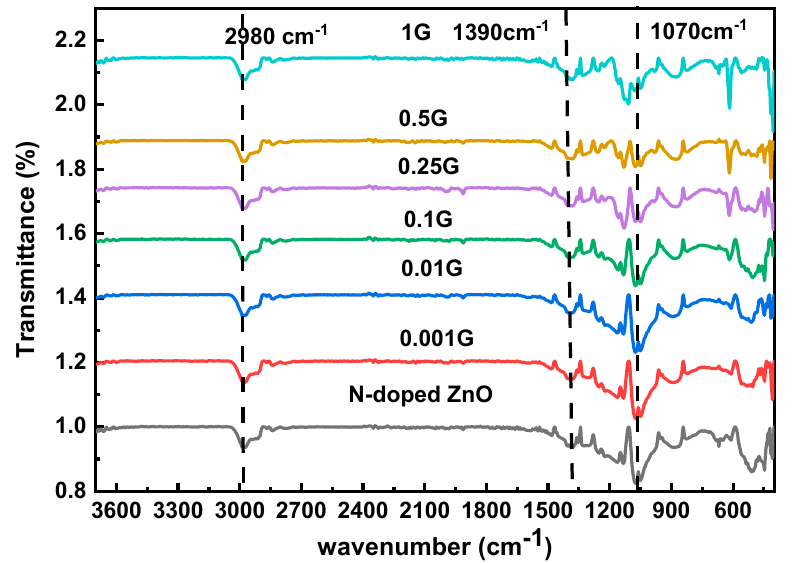
Figure 1. FT-IR spectra of the N-doped ZnO and G/N-doped ZnO nanoparticles with different concentrations of graphene.